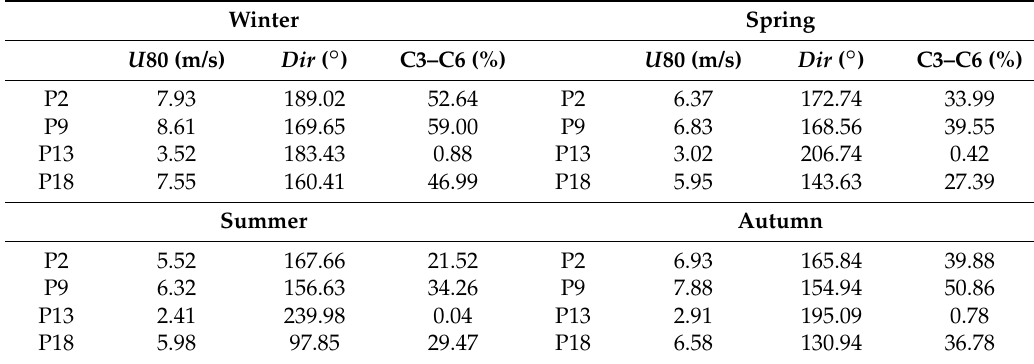
Table 3. U 80 seasonal statistics indicated for some of the reference sites. The results are related to the ERA-Interim data and cover the interval from January 1998 to December 2017. Winter